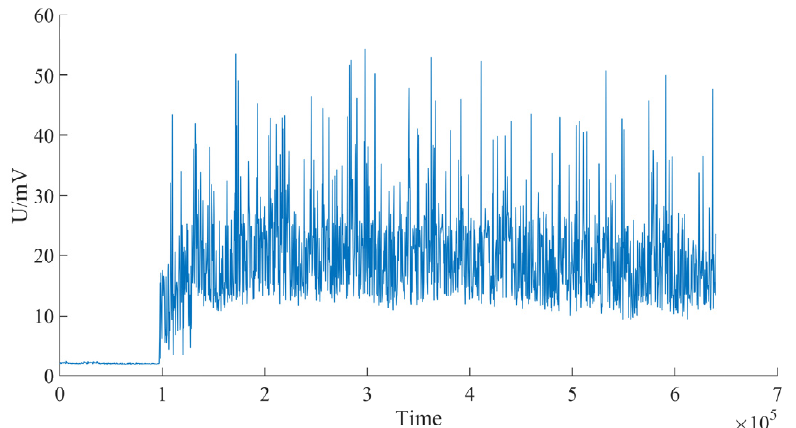
Figure 14. Thermoelectric potential curve measured by arti fi cial thermocouple.